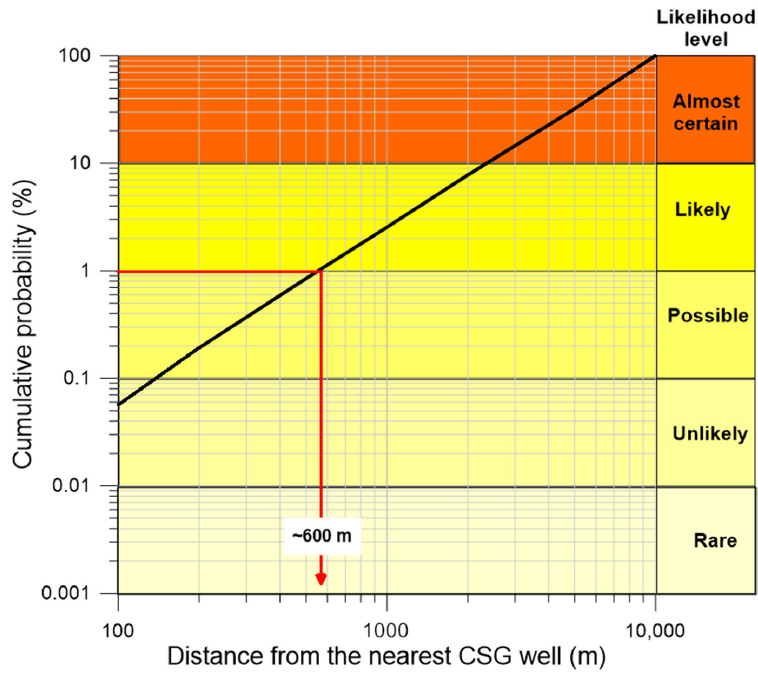
Figure 10. Empirical cumulative distribution of proximity between water bores and coal seam gas wells for the Narrabri catchment.